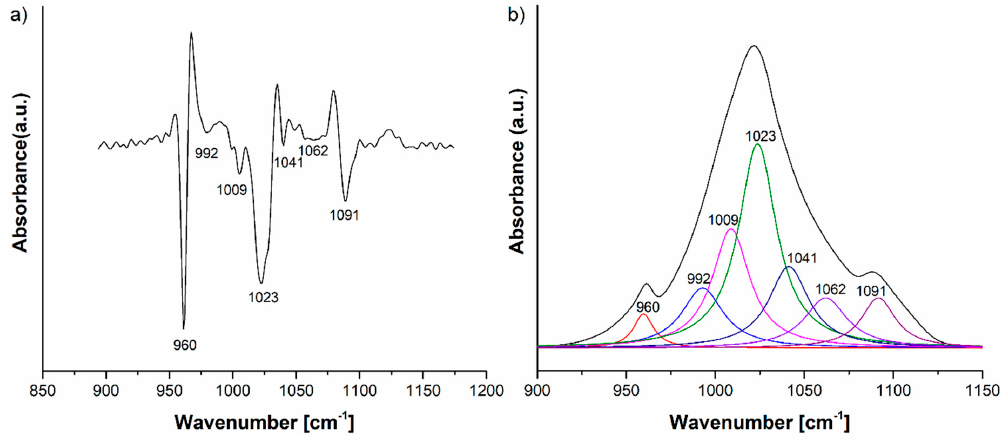
Figure 5. ( a ) Second derivative and ( b ) FTIR deconvoluted spectra of the HAp-B IR spectrum in the 800–1200 cm − 1 domain.